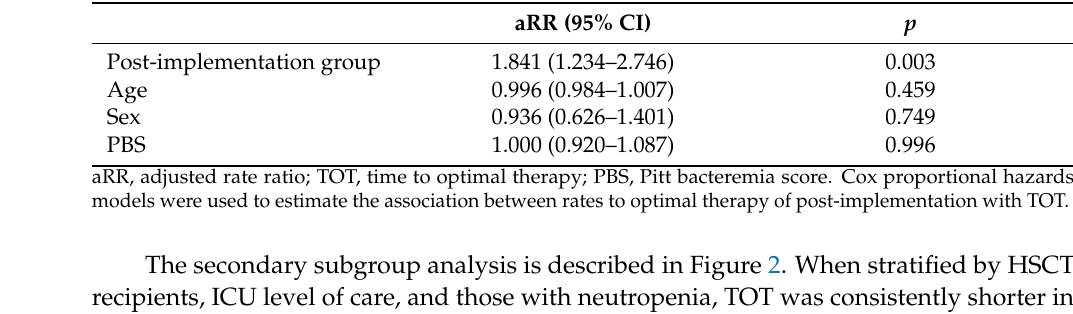
Table 3. Cox proportional model for time to optimal